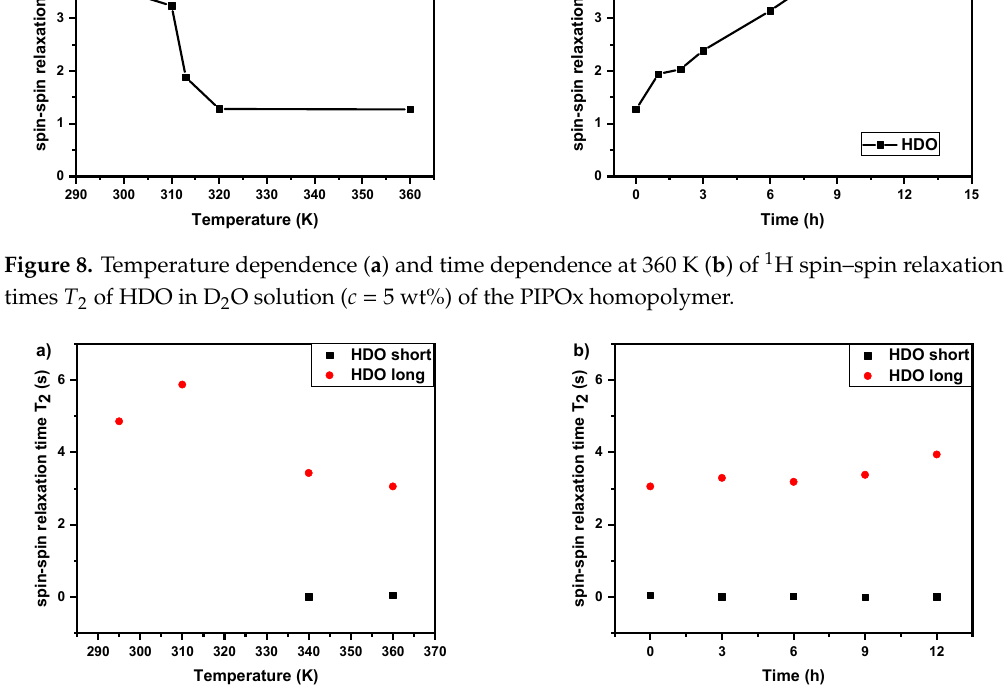
Figure 9. Temperature dependence ( a ) and time dependence at 360 K ( b ) of 1 H spin–spin relaxation times T 2 of HDO in D 2 O solution ( c = 5 wt%) of the P(MeOx/EtOx)(7/93) copolymer.